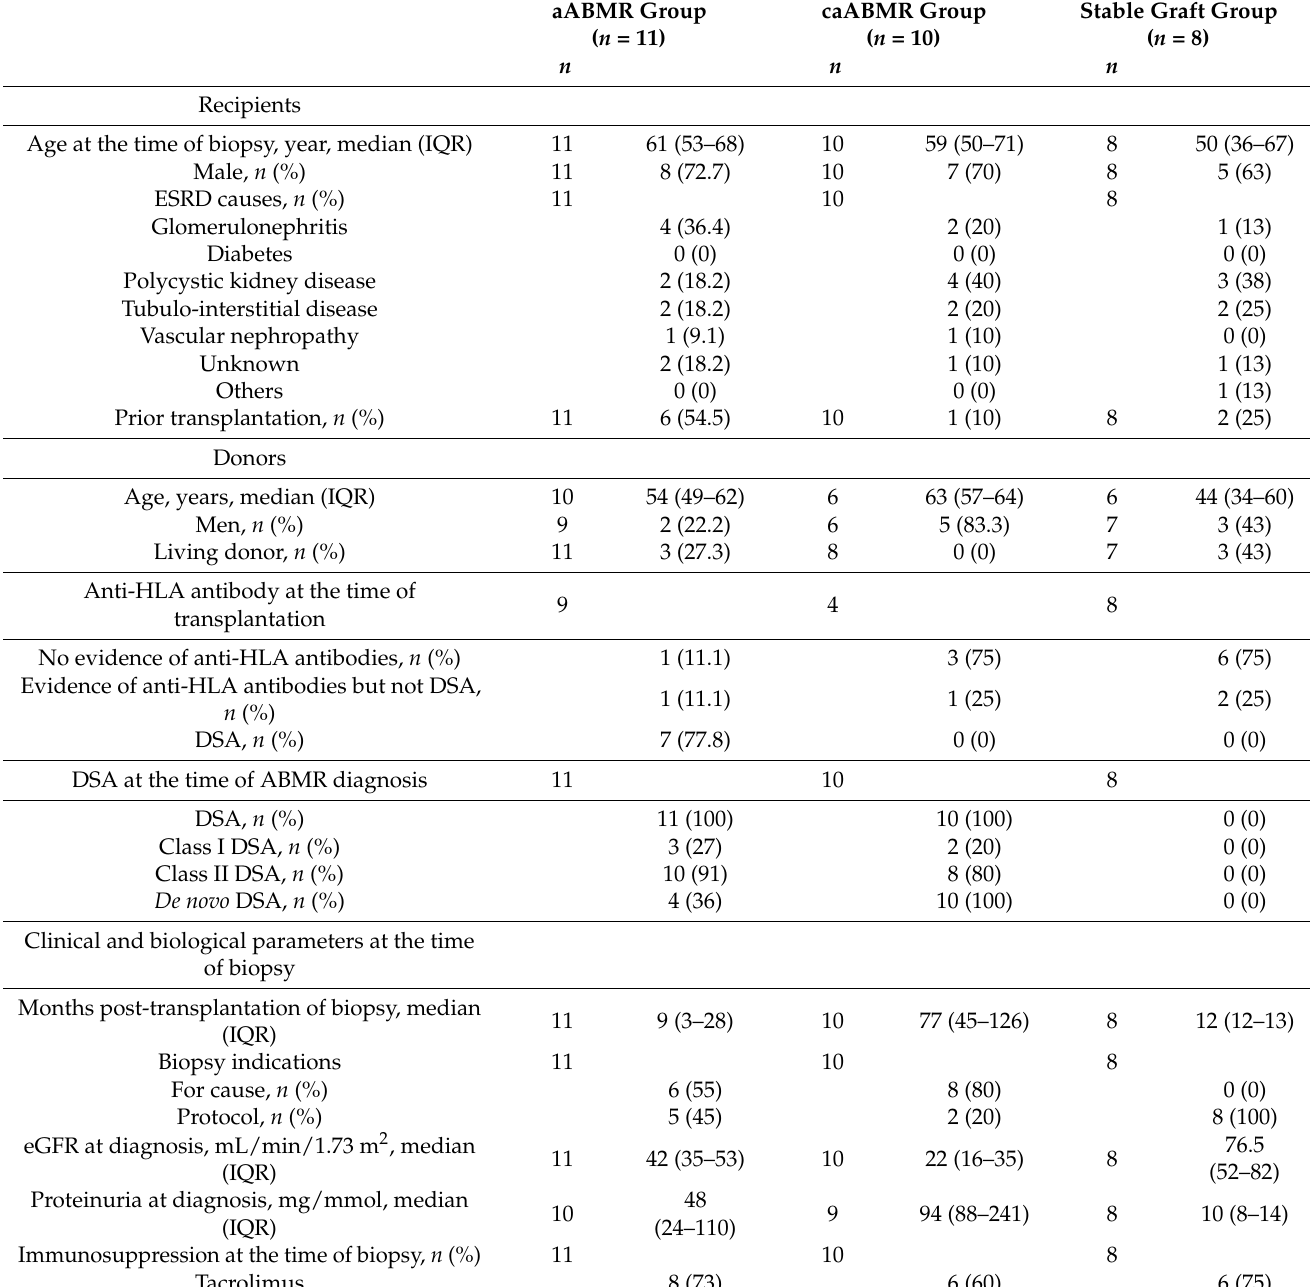
Table 1 summarizes all relevant clinical, biological and histological characteristics. Figure 1 describes the overall analytical strategy. Table 1. Demographical characteristics of the